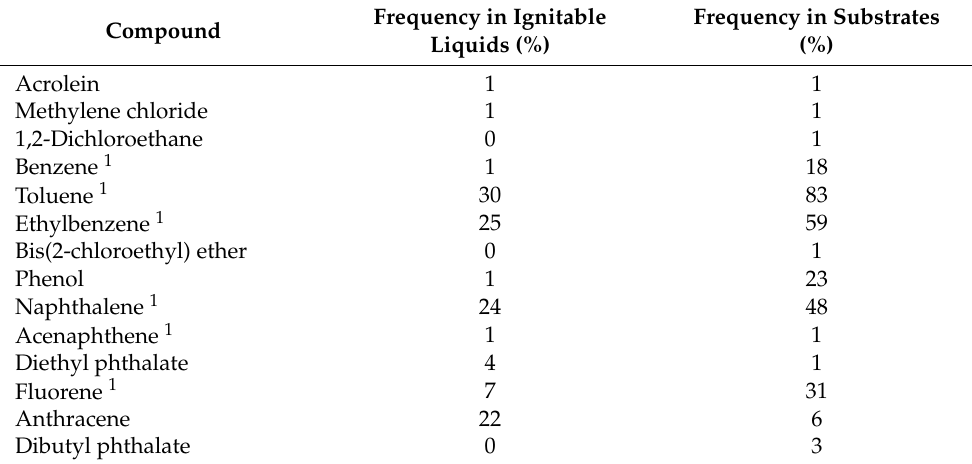
Table 1. Frequencies of priority pollutant compounds identified in 1047 ignitable liquids and 553 substrates found in ILRC and Substrate databases. Frequency in Ignitable Compound Liquids